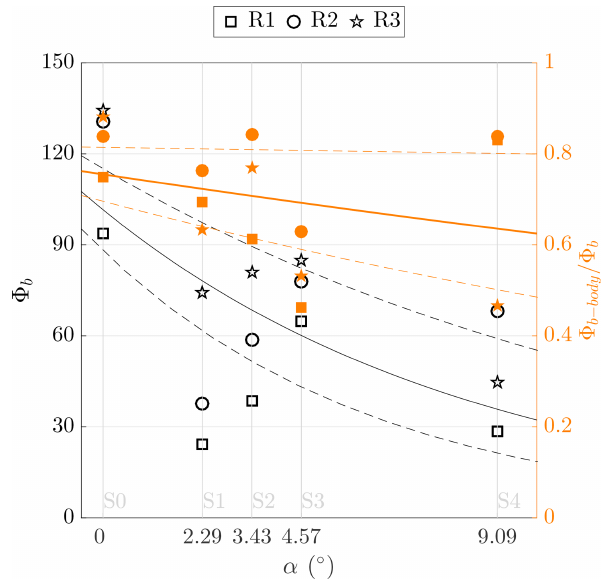
Figure 13. Potential erosion capacity for gravity currents (left axis) developed with different lock inclinations and rate of potential bot- tom erosion due to the body of the gravity current on the total bot- tom erosion capacity, (cid:56) b-body /(cid:56)b (right axis). The exponential fit- ting lines are reported in order to give evidence of the general trend, together with the 85% confidence intervals (dashed